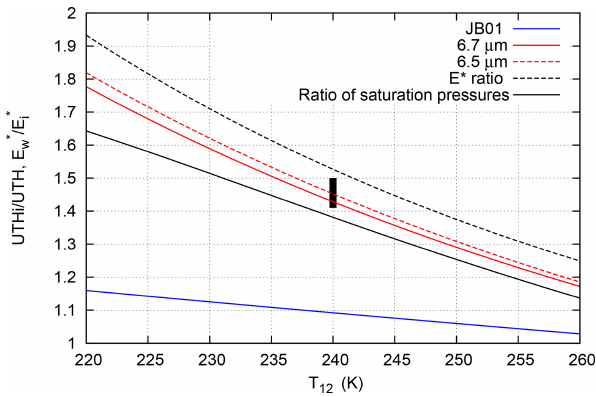
Figure 11. Ratio of UTHi vs. UTH retrieval (blue: JB01; red: present paper using the retrieval for 6 . 7µm (solid) and the same but for the 6 . 5µm retrieval (dashed)) as a function of brightness temperature. The other curves are for comparison. The black solid (T ) (Mur- line is the ratio of saturation vapour pressures e ∗ w (T )/e ∗ i phy and Koop, 2005), and the black dashed line represents the ra- (T ) functions (Eq. 16 with the cor- tio of the corresponding E ∗ w/i responding parameters from Table 1). The black bar in the middle represents more than 1600 values computed by integration over the actual RH, RH with respect to ice and T profiles from the Linden- berg radiosoundings, assuming the lower integration limit is 245K (Eq. 10). Obviously, the second-order formula matches the actual data quite well, but the ratio obtained from the JB01 coefficients is quite